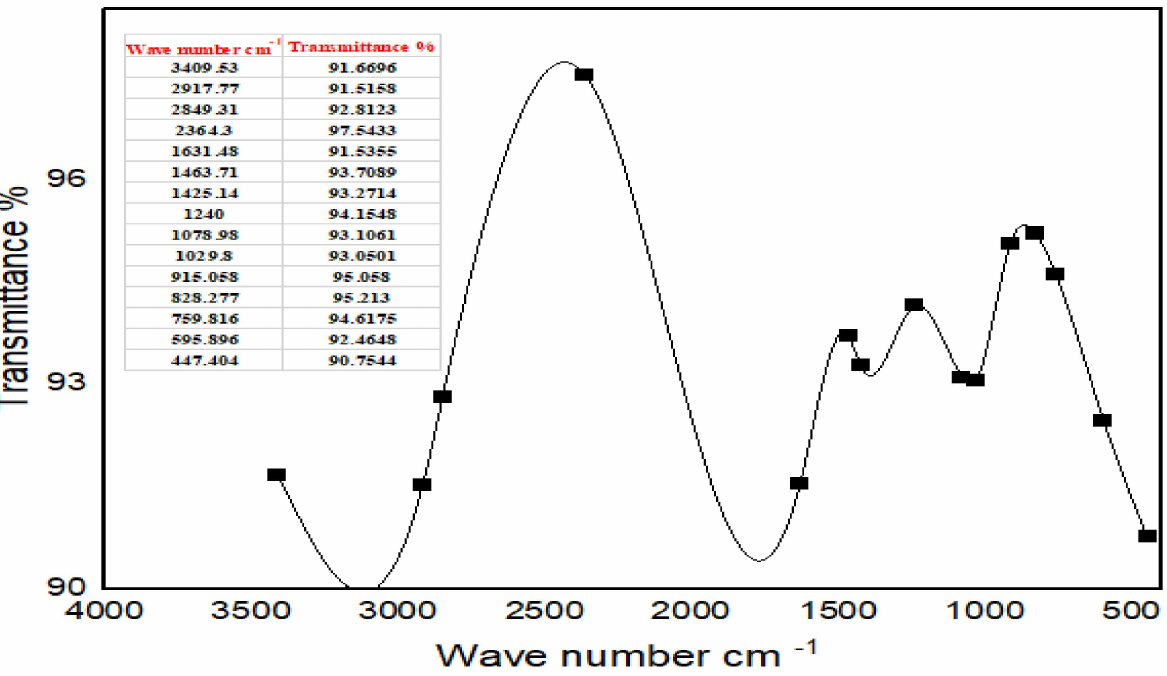
Figure 4. FTIR spectra of silver nanoparticles synthesized by the crude aqueous extract from Moringa and NaBH 4